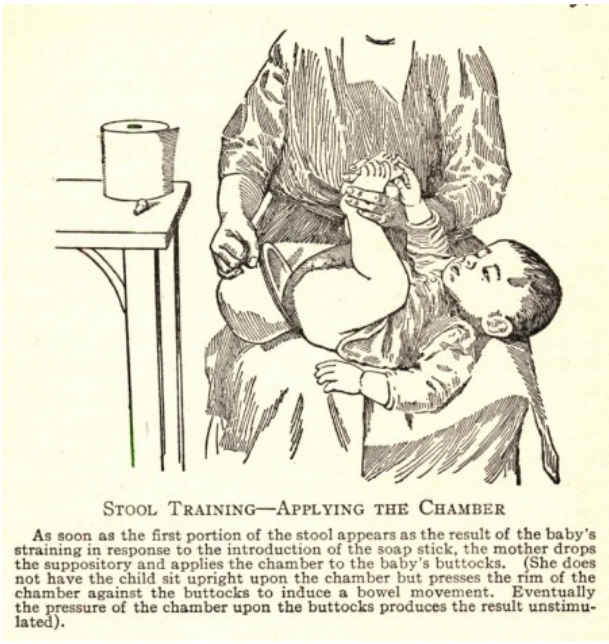
Figure 17. “Applying the Chamber”.